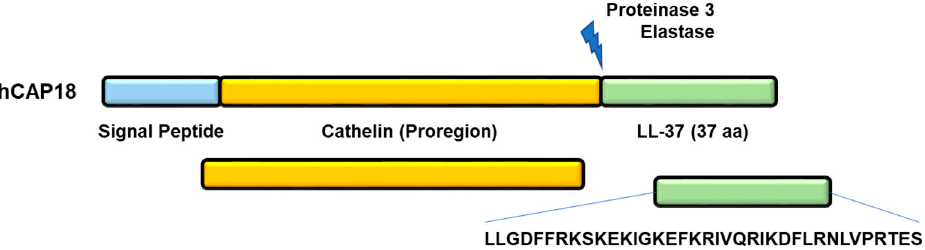
Figure 1. Maturation of hCAP18 precursor protein and naturally occurring generation of the endog- enous fragment LL-37. nous fragment